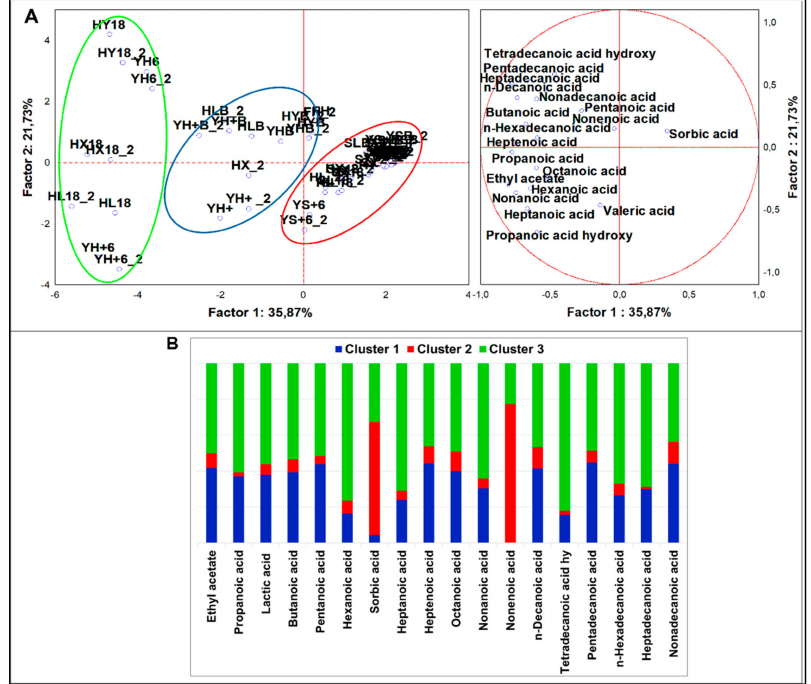
Figure 6. ( A ) PCA of cases and variables on organic acids ( p < 0.05); ( B ) K-means clustering analysis ( p <